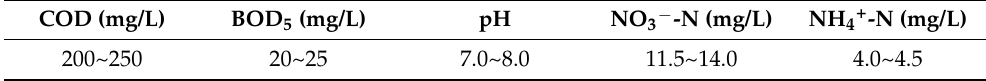
Table 1. Main water quality parameters of